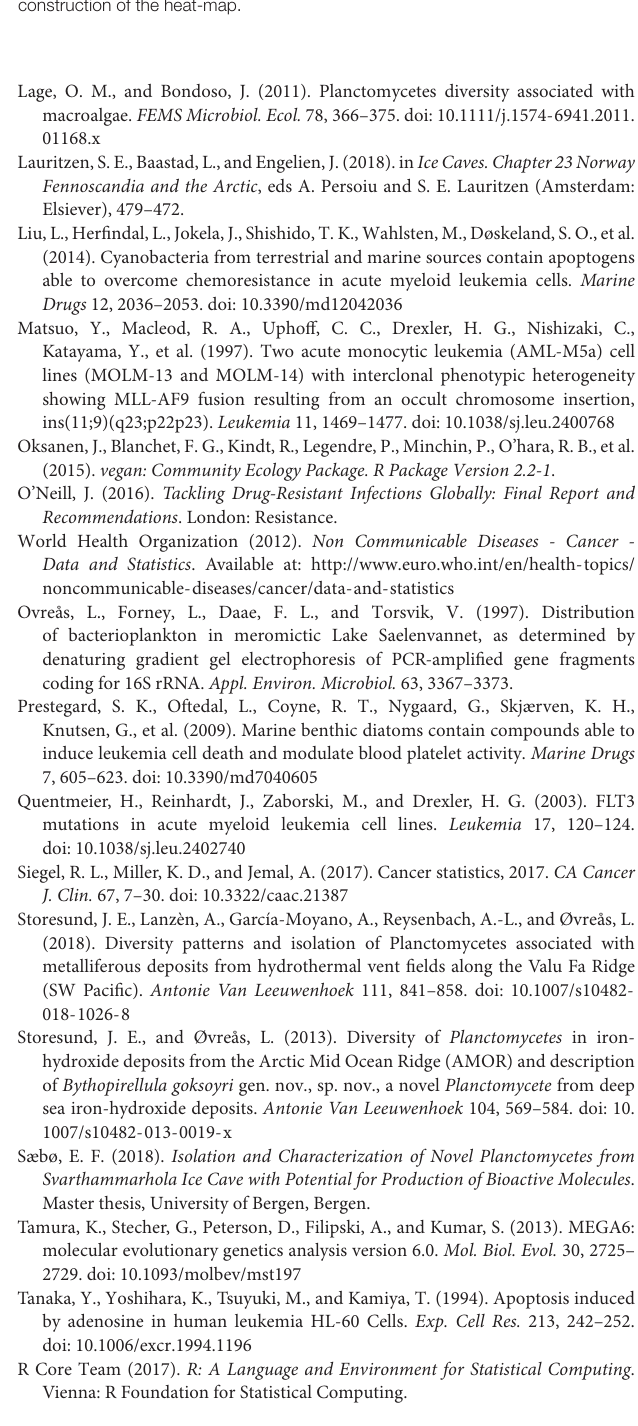
Invariant sites (G + I) indicating the relationship of the Planctomycetes strains tested in this work. Bar – 0.05 substitutions per 100 nucleotides. The planctomycete Candidatus Scalindua brodae was used as outgroup. FIGURE S2 | Examples of MOLM-13 cells stained with the DNA binding specific Hoechst dye. (A) Control cells and (B) cells exposed to organic extracts of strain UC49.1. The apoptotic nuclei are bright, condensed or fragmented. TABLE S1 | Data based on the different degrees of toxicity used for the construction of the